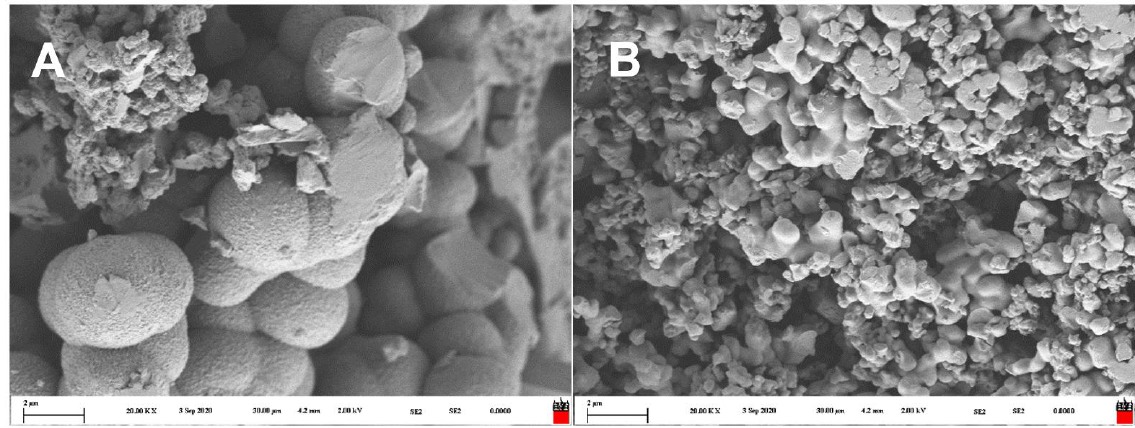
Figure 4. SEM images showing morphology of polymers 4aa ( A ) and 4ba ( B ) taken at 2 × 10 4 magnification.